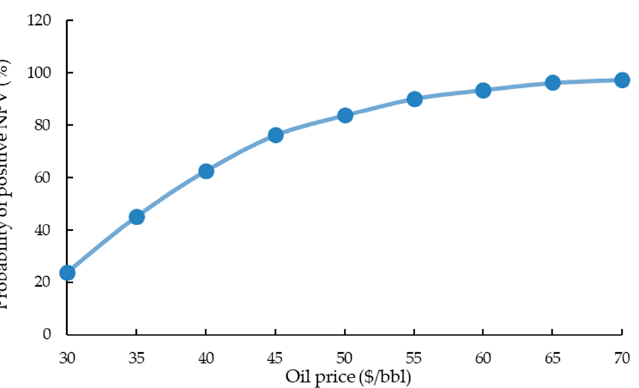
Figure 6. Probability of positive NPV under different oil prices (considering uncertainty).